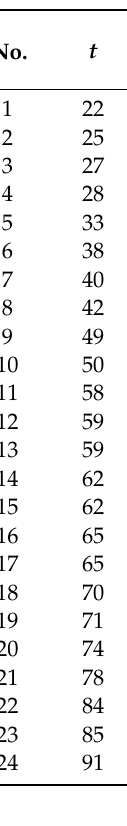
Table 5. Minimum phase shift Ψ min between binary sequences produced by a TPG designed on the basis of DT-LFSR registers, calculated for various numbers of scan